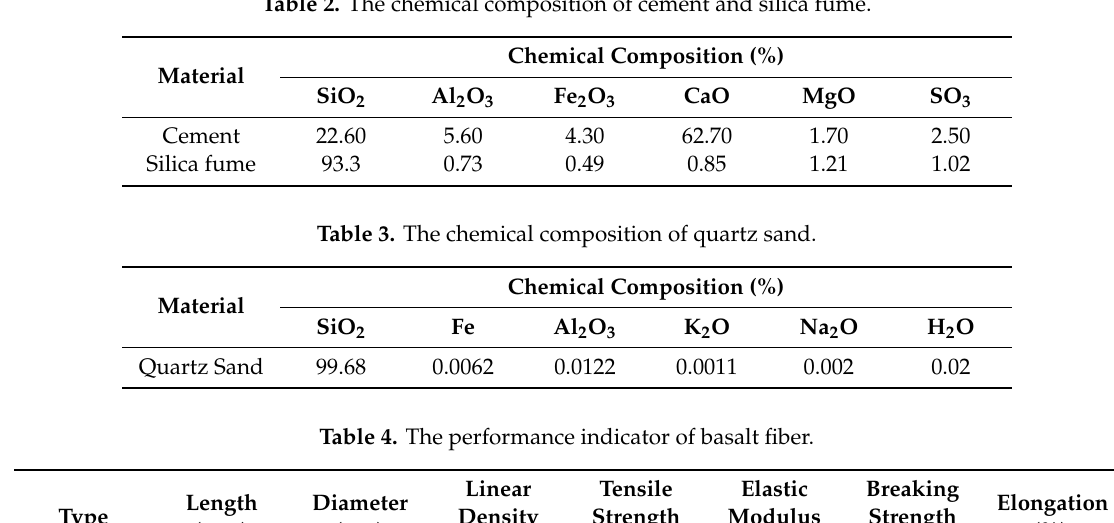
Table 2. The chemical composition of cement and silica fume.